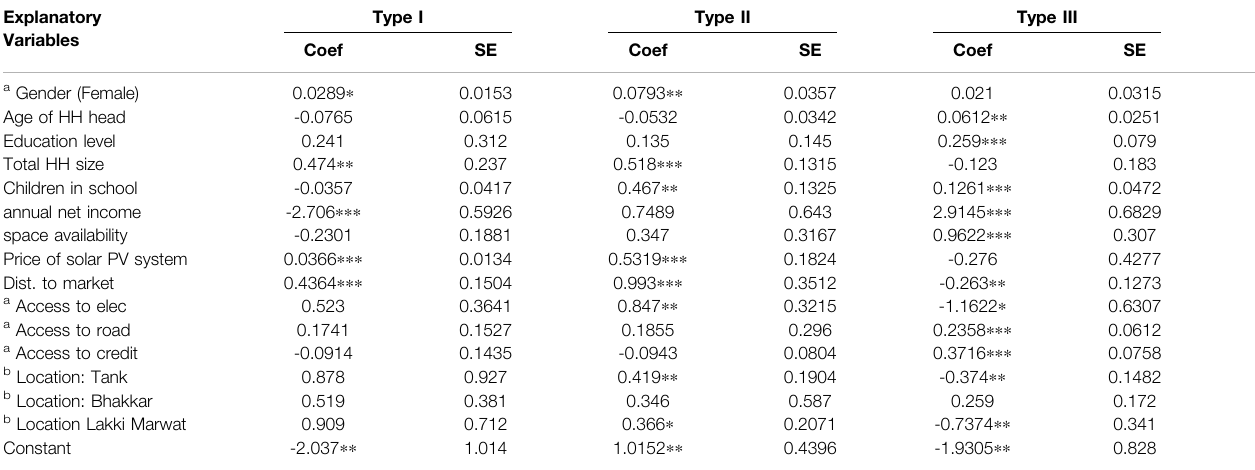
TABLE 5 | Factors affecting the household ’ s choice for different solar PV system types: MVP model estimation. Explanatory